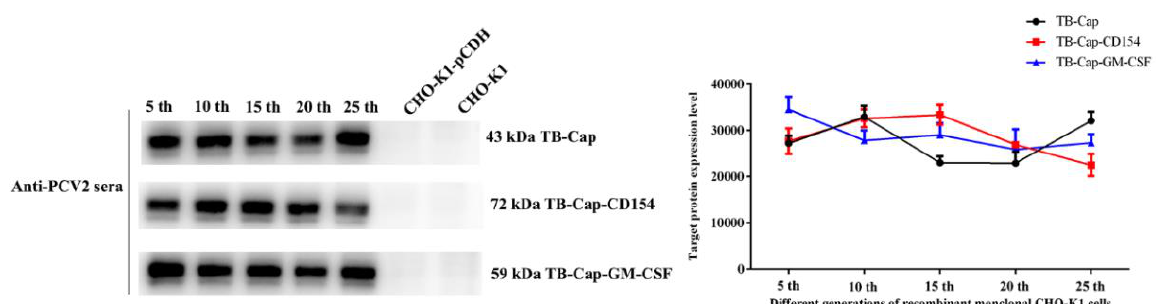
Figure 4. Stability identification of monoclonal cells. Stability identification of monoclonal cells lines. Western blot was used to analyze the fusion protein expression of the 5th, 10th, 15th, 20th and 25th generations of monoclonal cell lines, and Image J was used to quantify the protein gray value. All data shown represent the mean ± SD calculated from three independent experiments.